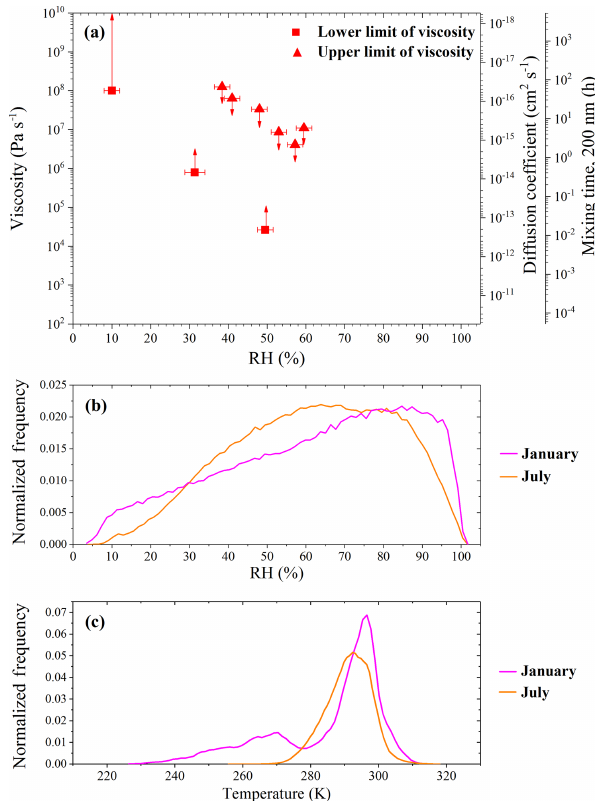
Figure 5. Panel (a) shows viscosities, diffusion coefficients, and mixing times of organic molecules within 200nm diesel fuel SOA. Panels (b) and (c) represent the RH frequency distribution and the temperature frequency distribution in the planetary boundary layer when the average concentrations of organic aerosol are higher than 0.5µgm − 3 at the surface based on GEOS-Chem (Ullmann et al., 2019). The frequency distributions were calculated using monthly mean meteorological data from GEOS-Chem version v10-01 and data were only included when the monthly mean concentrations of organic aerosol at the surface were greater than 0.5µgm − 3 (Maclean et al.,